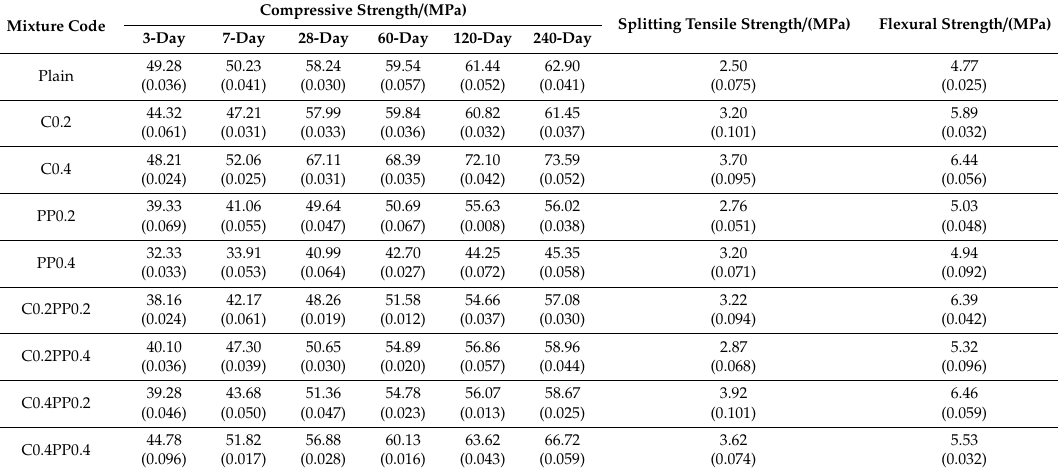
Figure 7. The 28-day compressive strength and corresponding specific strength of LWAC. Table 9. Mechanical property test results of